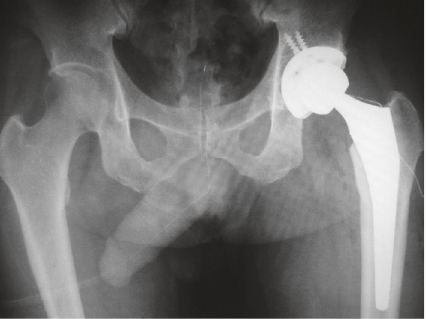
Figure 5: Radiographs of the hip joint after total hip